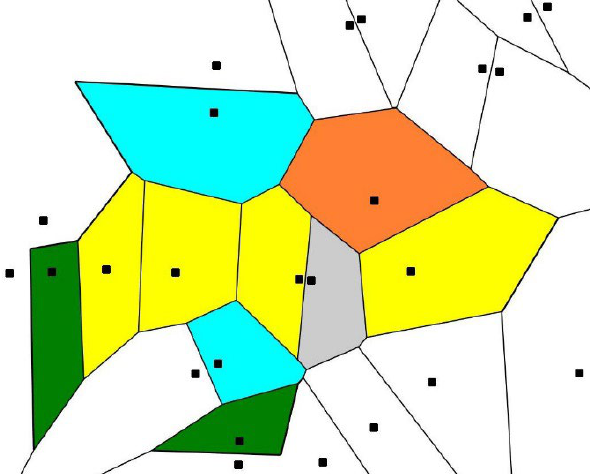
Figure 4. Voronoi diagram (tessellation) emerging from the initial 25 randomly placed points, also called seeds (represented with black squares); green polygons are quadrangles; yellow polygons are pentagons; the grey polygon is a hexagon; blue polygons are heptagons; the orange polygon is an octagon. Are the seeds ordered? The answer to this question is supplied by calculation of the Voronoi (Shannon) entropy of the pattern.